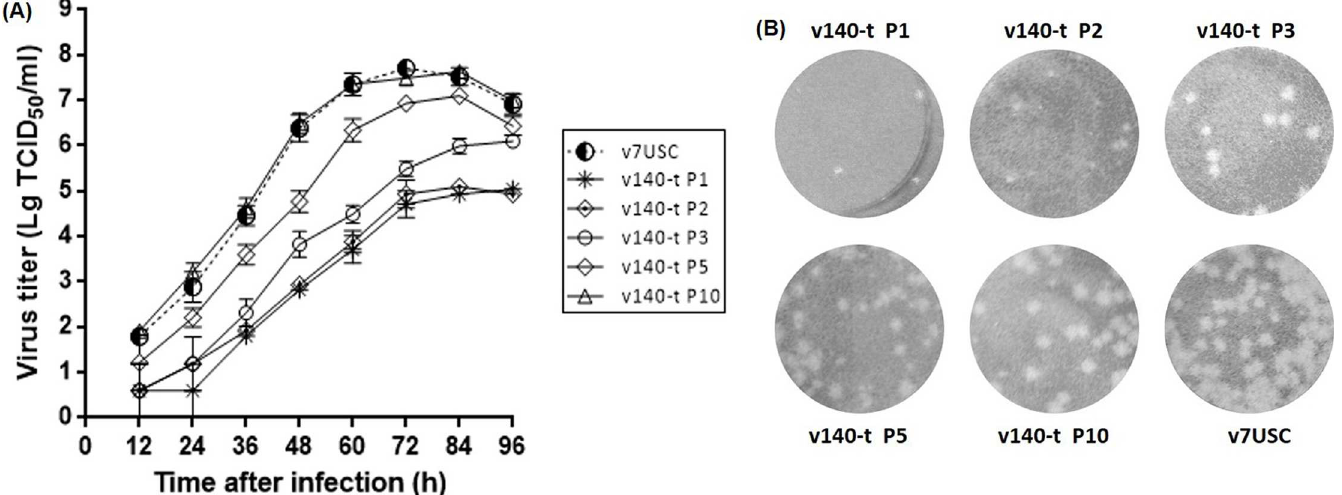
Fig 7. Viral growth and plaques characteristics of v140-t. A: Analysis of v140-t (P1, P3, P5 and P10) growth in MARC-145 cells. Culture supernatants were collected at the indicated times and titrated. B: Analysis v140-t (P1, P3, P5 and P10) plaques characteristics in MARC-145 cells. MARC-145 monolayers were infected with v7USC, v140-t P1, v140-t P3, v140-t P5, and v140-t P10, respectively, overlaid with low melting-point agarose and stained with 5% (w/v) crystal violet in 20% ethanol at 5 dpi.